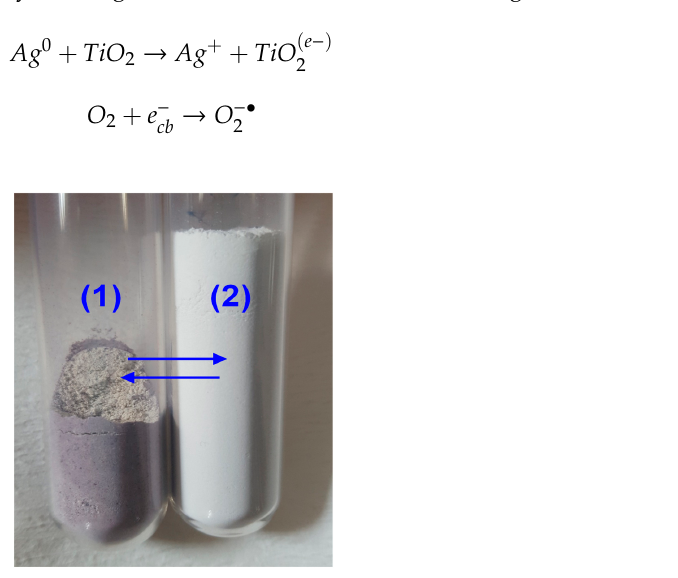
Figure 6. S3 sample after few weeks under ambient conditions ( 1 ), initial white color of S3 sample return after shaking ( 2 ).